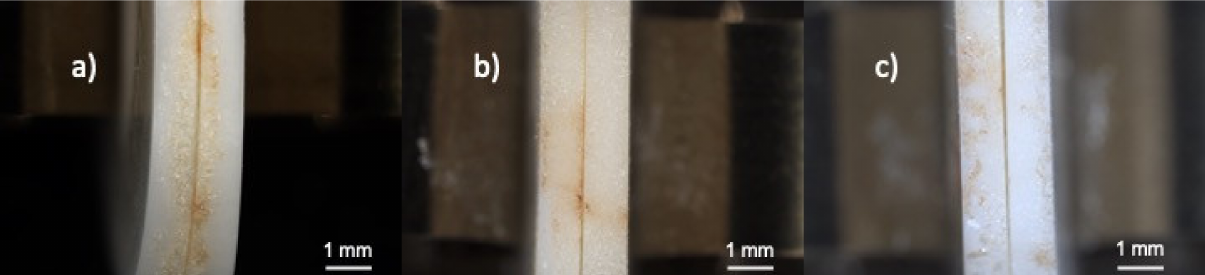
Figure 1. Light microscope images of bonded alumina samples after pressureless treatment in 750 ◦ C with: ( a ) Bi 2 O 3 -5% ZnO interlayer, ( b ) Bi 2 O 3 -10% ZnO interlayer, ( c ) Bi 2 O 3 -15% ZnO interlayer. EDX analyses of sample cross-sections with a ZnO weight of 10, 15 and 25% were performed to examine the diffusion mechanism occurring during the bonding (Figures